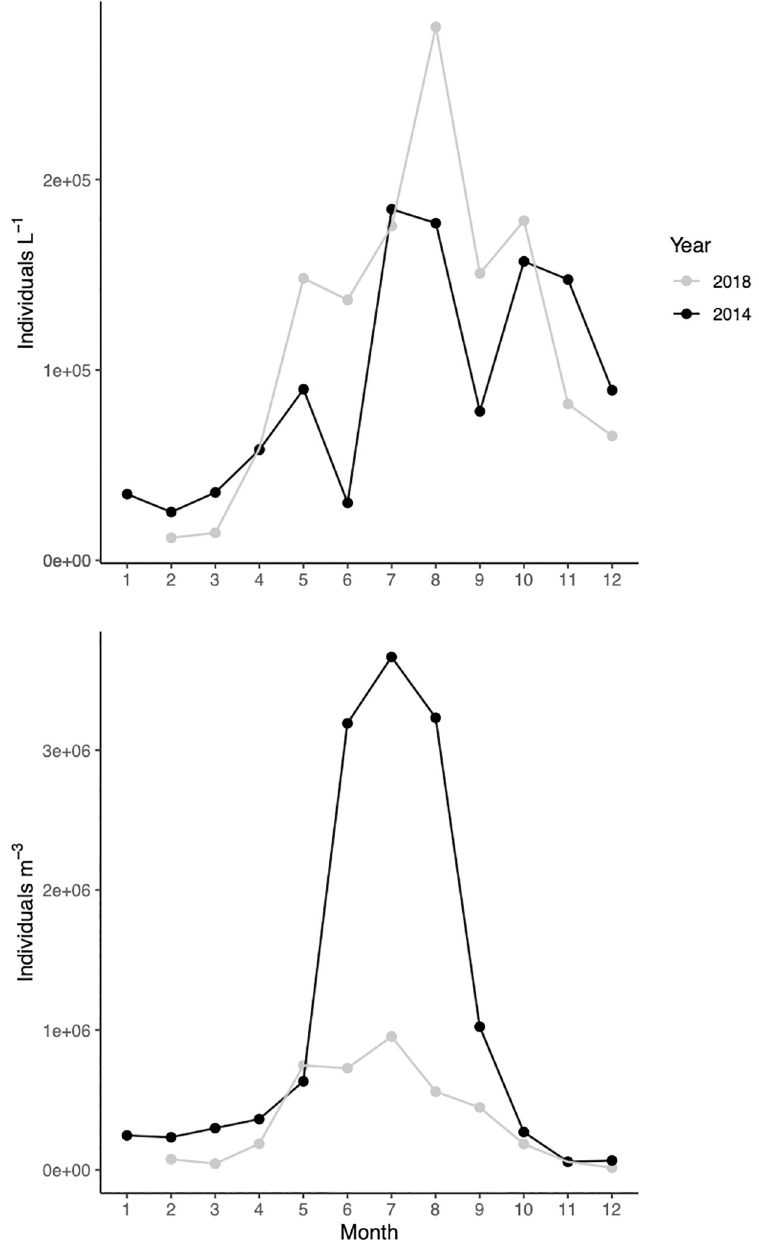
Fig 7. Seasonal dynamics of total metazooplankton (lower) and ciliates (upper) in 2014 (gray line) and 2018 (black